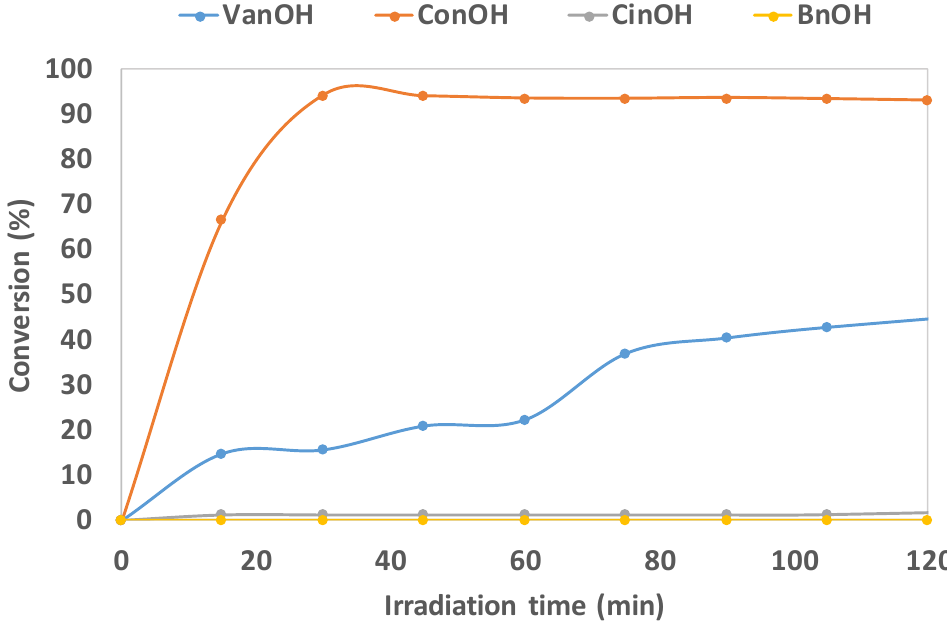
Figure 8. Visible light (515 nm) activity of other aromatic alcohols with bimetallic CuA-Au/TiO 2 in the batch system.